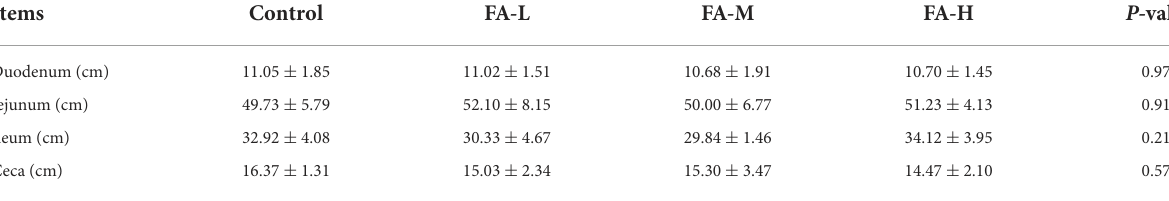
TABLE 4 Effects of dietary supplementation of FA on intestine length of Xianju yellow chickens (Mean ± SD).